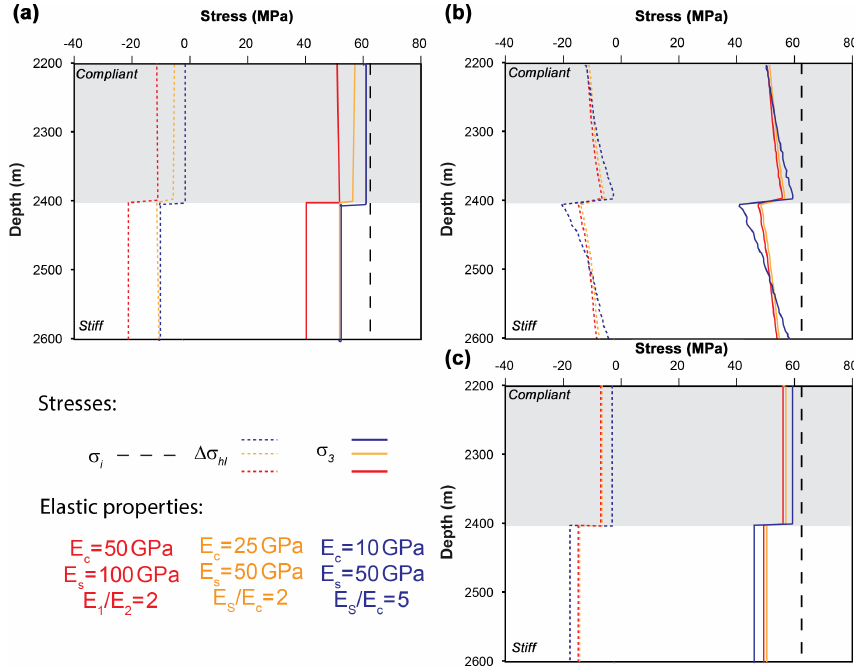
Figure 2. Examples of stress predictions, σ 3 , and local stress corrections, (cid:49)σ hl , in the strain- (a) and stress-driven models (b, c) . (a– c) Bilayer media of a 200m thick compliant layer (top) with Young’s modulus E c and a 200m thick stiff layer (bottom) with Young’s modulus E s . Various combinations of Young’s moduli are used as indicated in the figure. The Poisson’s ratio is constant at 0.25. (a) A regional strain perturbation of 0.002mm − 1 extension is imposed. Stresses are calculated using the analytic solution described in Sect. 2.2. (b, c) A regional stress perturbation of − 10MPa is imposed. Stresses are calculated using the numerical (b) and analytic solution (c) as described in Appendix B. The initial horizontal stress is the lithostatic stress ( σ i = σ l ) calculated using an average 2400m depth and an average density of 2600kgm − 3 . Local stress corrections ( (cid:49)σ hl ) and the minimum horizontal stress ( σ 3 ) are the dotted and continuous colored lines for indicated combinations of Young’s